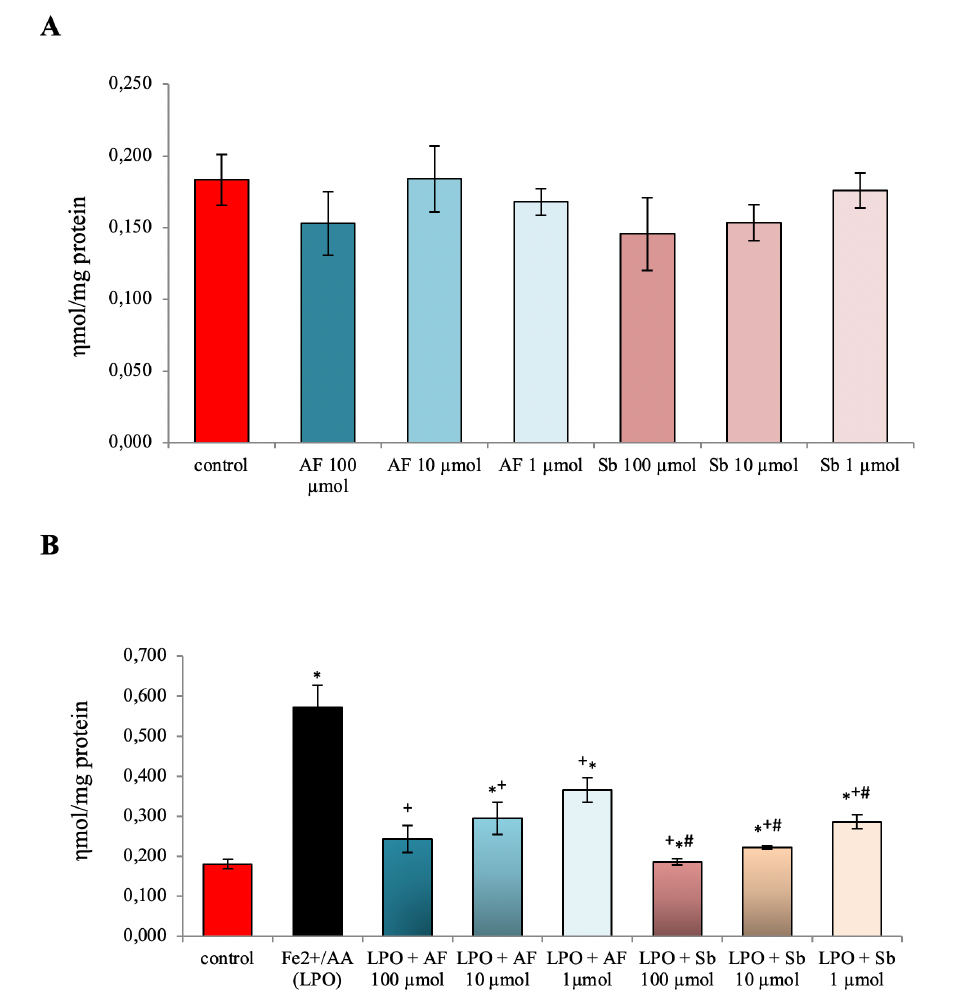
FIGURE 2 - Effect of alcesefoliside (AF) and silybin (Sb) on MDA quantity assessed in pure microsomes (2A) and in microsomes with Fe 2+ /AA - induced LPO (2B). Mean ± SEM (n = 6). * p < 0.05 vs control; + p < 0.05 vs induced LPO; # p < 0.05 vs respective equimolar concentration